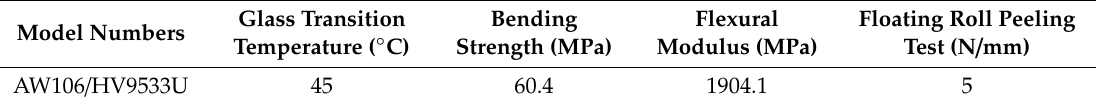
Table 4. Typical properties of adhesive cured at 40 ◦ C for 16 hours (testing temperature 25 ◦